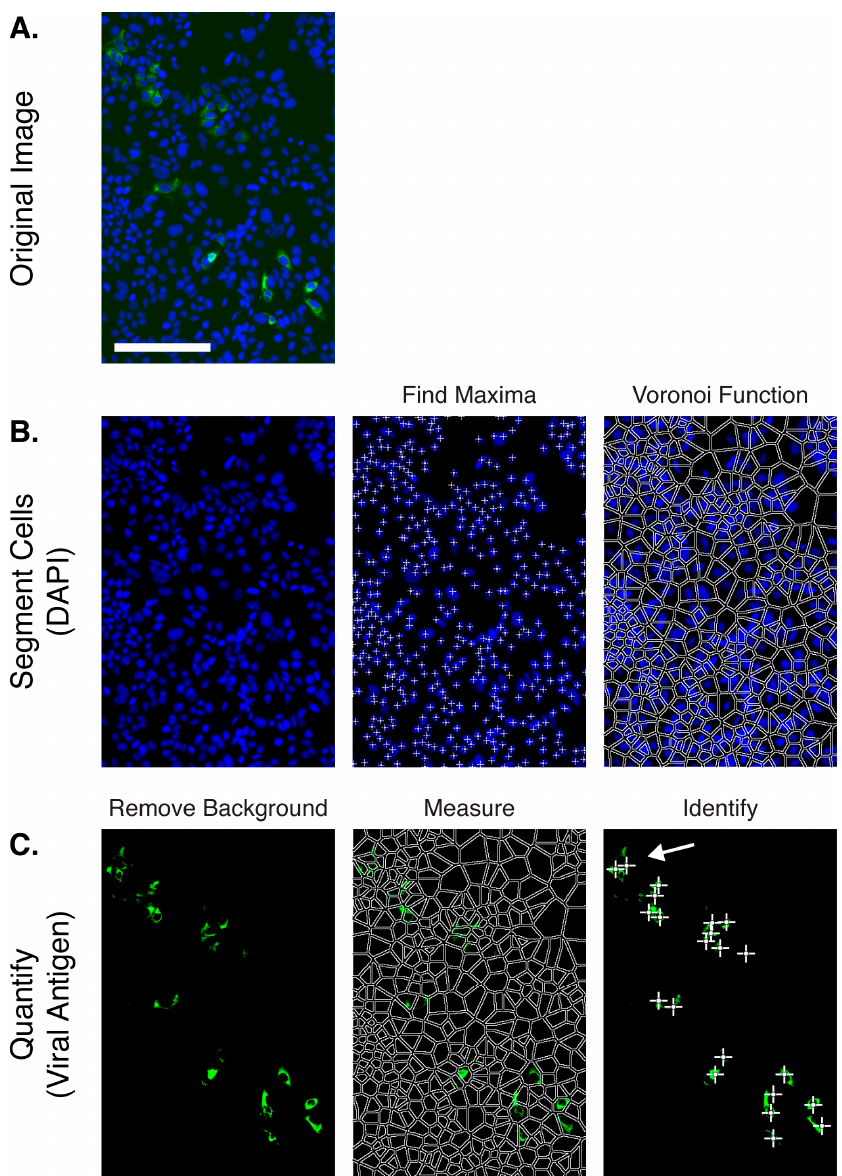
Figure 2. Infection Counter analysis workflow. ( A ) A representative unprocessed image of Huh-7.5 cells infected with J6/JFH HCVcc, cells were fixed 48 h post-inoculation and stained for viral antigen NS5A (green), nuclear DNA was counterstained with DAPI (blue), scale bar 200 µ m; ( B ) Cells were first segmented using the DAPI channel: individual nuclei were identified using the in-built ImageJ ‘Find Maxima’ function, and the locations of these were then used to generate a Voronoi mosaic (in-built ImageJ ’Voronoi’ function) to approximate individual cell bodies; ( C ) Following background correction, the fluorescence intensity of viral antigen associated with each cell was measured and positive cells were identified using an empirically chosen signal threshold (in this image 4.86% of cells were scored as positive). The analysis method correctly identified the majority of cell culture proficient (HCVcc) infected cells (white crosshairs), but miscounted a minority of cells; for instance, the white arrow indicates a group of four cells that has been scored as two by the